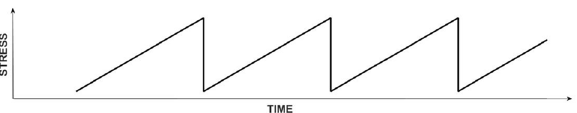
Figure 6. Schematic presentation of the earthquake generation process. Tectonic stress is slowly accumulated along the fault until it reaches local strength limit that is the critical stress required for failure. Then the earthquake occurs with a sharp stress drop. A new earthquake cycle